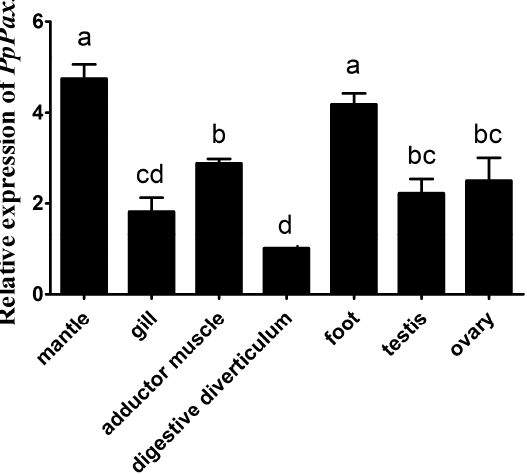
Figure 3. Relative expression of PpPax3 in various tissues of P. penguin estimated by qRT-PCR. Each bar was a mean of 6 pearl oysters. Error bars were the SD. Different letters (a, b, c and d) meaned significant difference ( P <